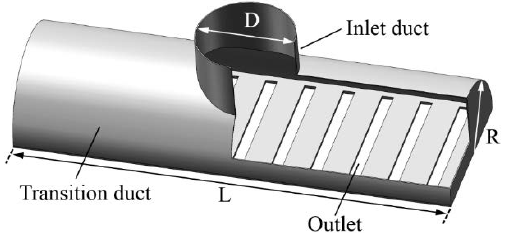
Figure 1. Conventional inlet header (Configuration A).